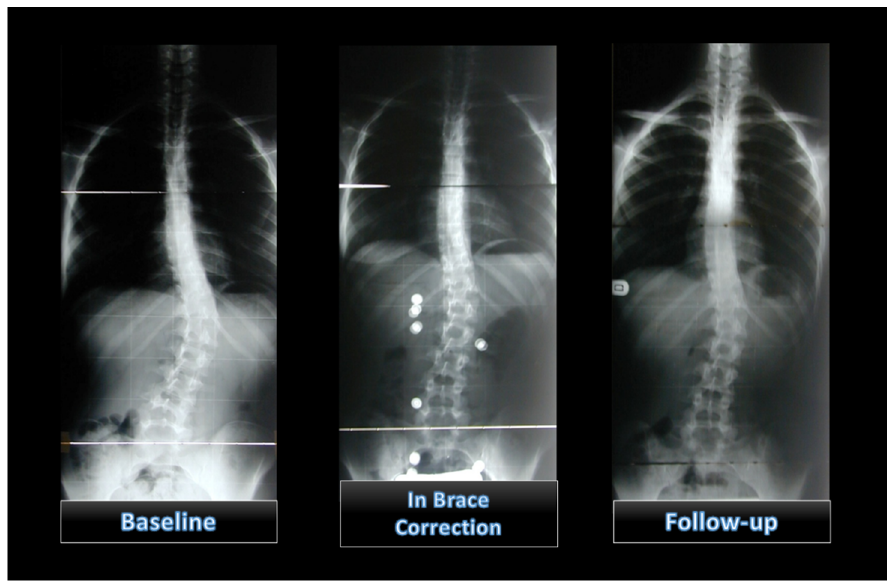
Figure 3. Patient X-rays that show changes over time.